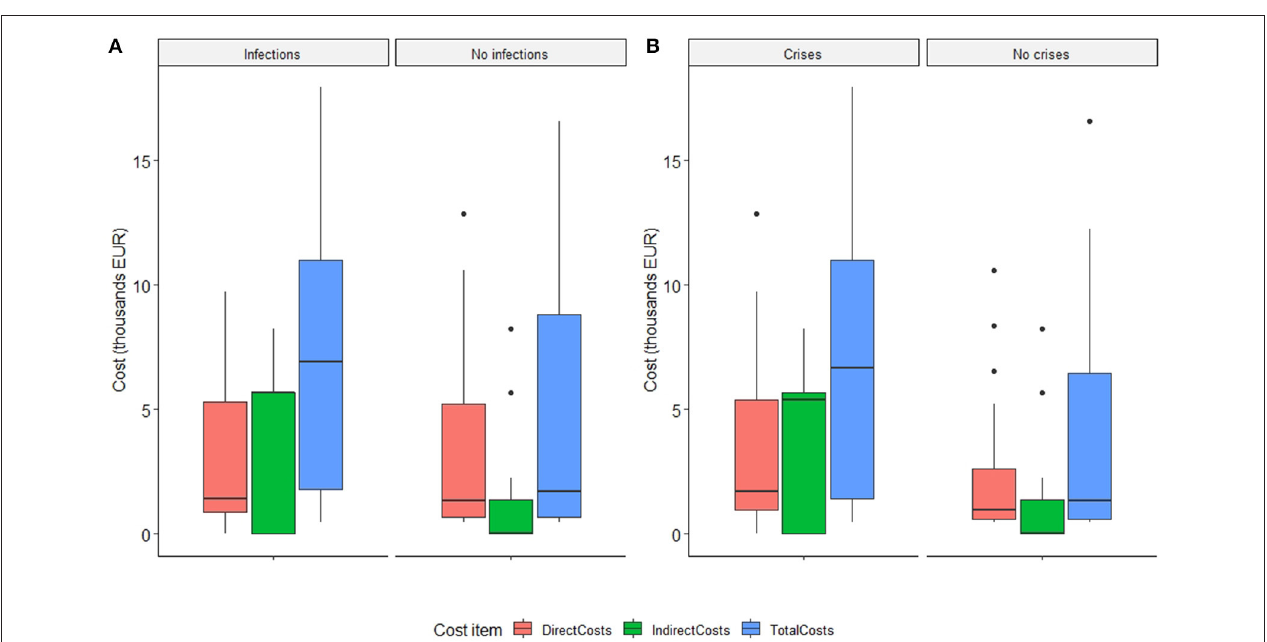
FIGURE 1 | Distribution of socio-economic burden in MG by infection rate (A) and crisis rate (B) .